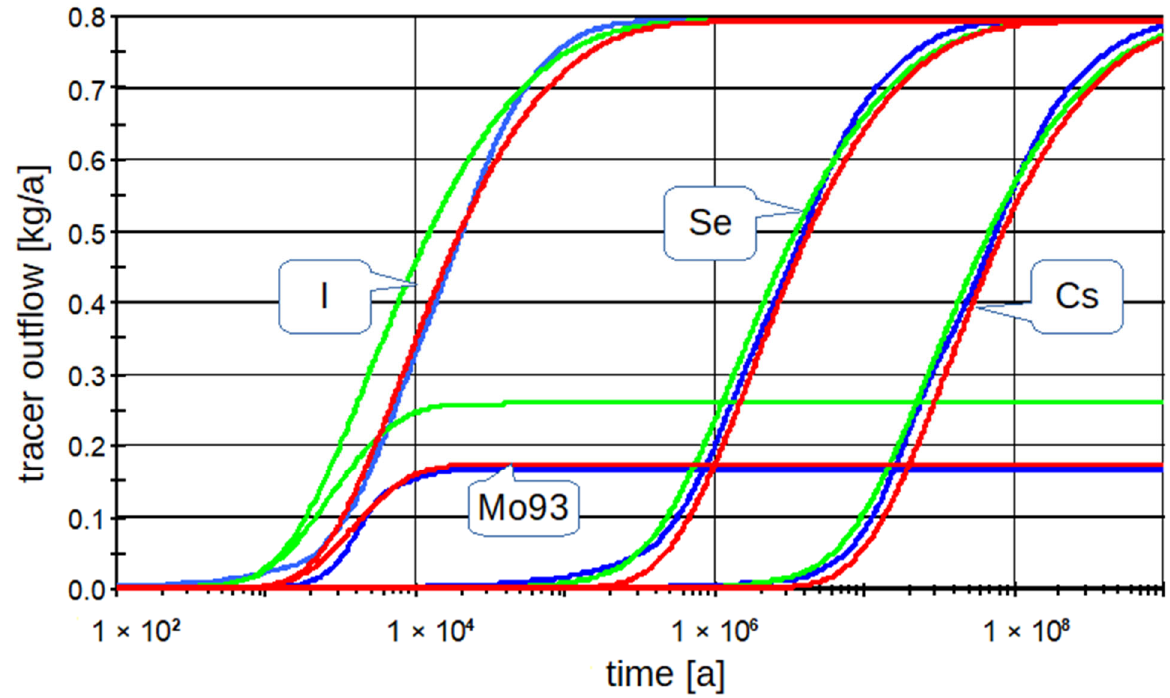
Figure 10. Comparison of tracer outflows at site l1 according to Flow123d (blue curves), according to the three pairs of cascade “Pipe” components set from postprocessing data of the non-sorbing tracer (green curves), and according to the optimized group of three pairs of cascade “Pipe” components (red curves).